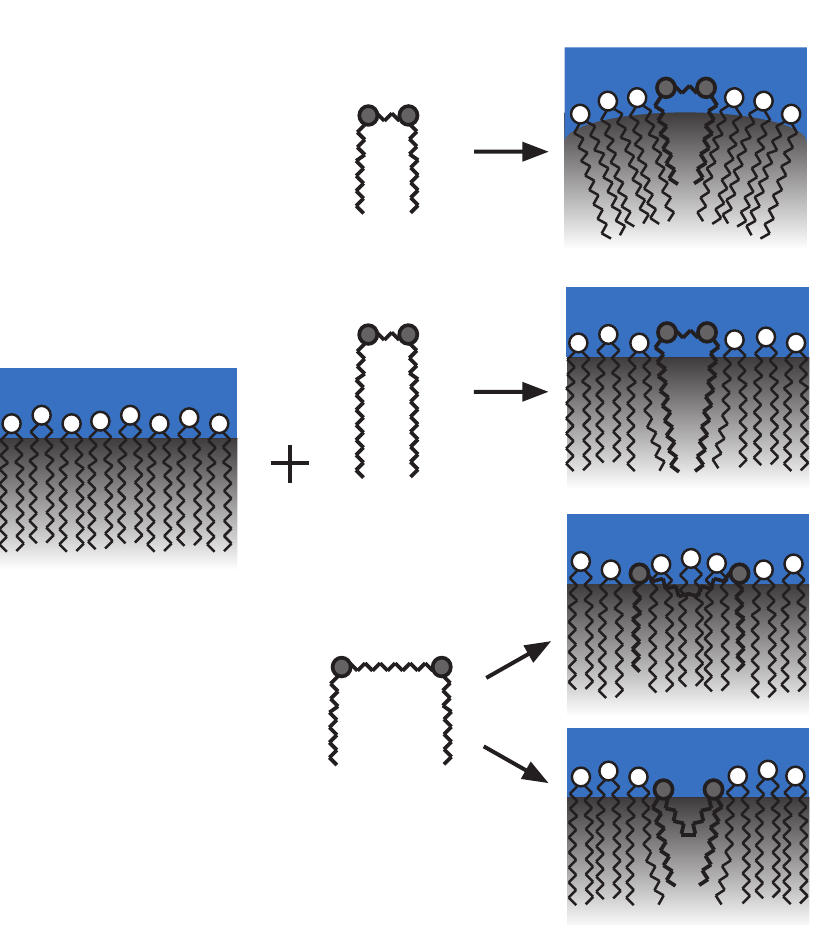
Figure 10. Pictorial illustration of the positioning and general conformational of gemini molecules embedded in the membrane, as well as the consequent morphological modification of the latter, based on the 31 P-NMR and MD simulation results. From the top to the bottom, gemini surfactants represented correspond to short spacer/short tail, short spacer/long tail and long spacer/short tail architectures.